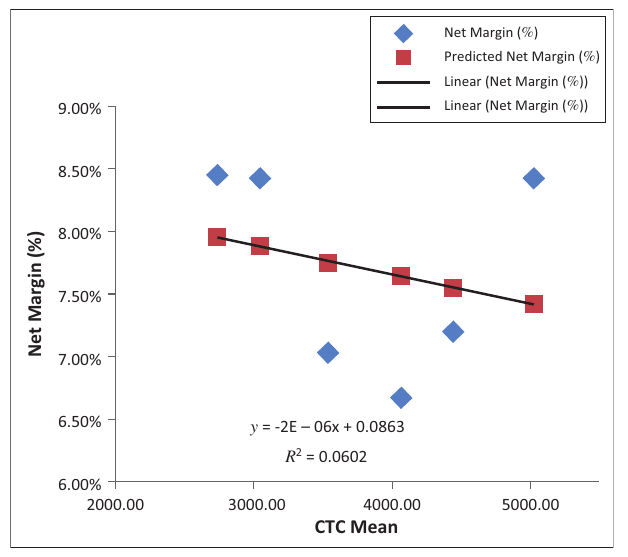
CTC, cost to company. FIGURE 10: Regression of net margin mean on cost to company mean.